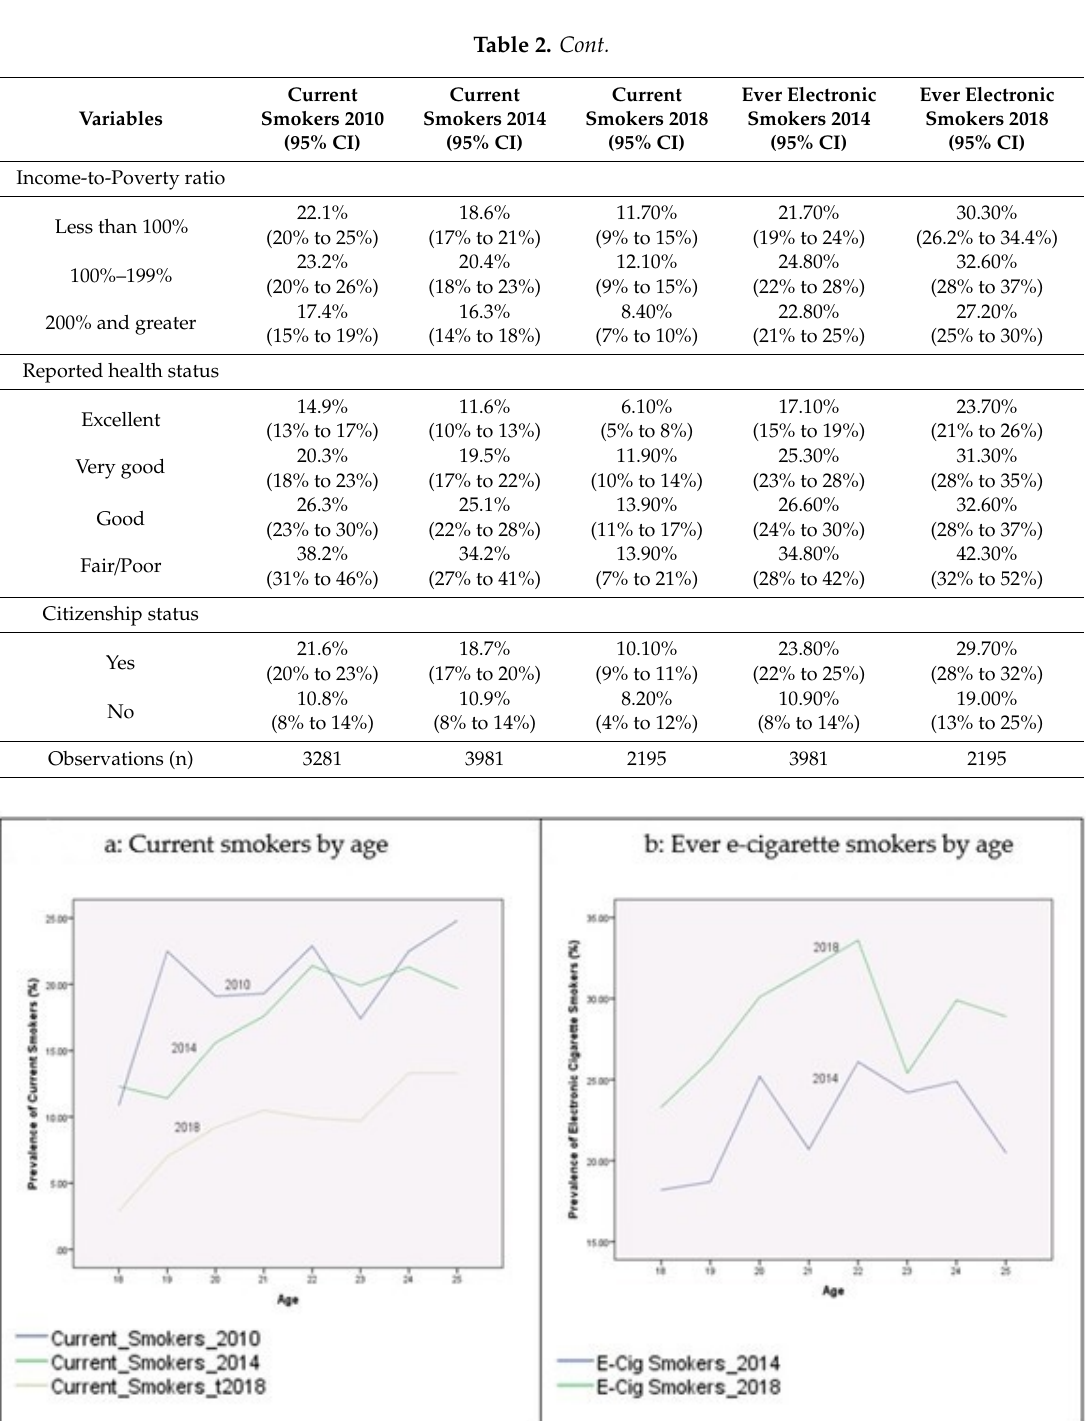
Figure 1. Prevalence of smoking behaviors by age, NHIS 2010–2018.